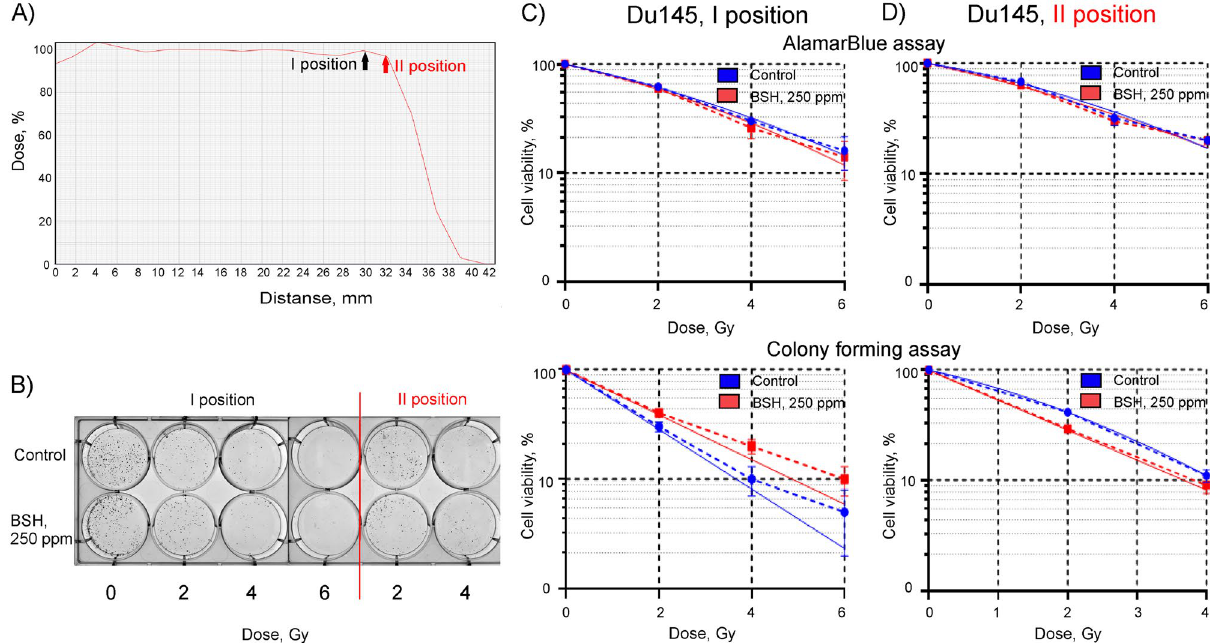
Figure 7. Effect of BSH on cell survivability after exposure to Bragg peak protons at different absorbed dose. ( A ) Dose profile for irradiation of cells with an 89.7 MeV clinical proton beam. In the majority of experiments, the cells were positioned at a depth of 30 mm (I position), and in some—at a depth of 32 mm (II position) along clinical proton SOBP. ( B ) Examples of colony forming assays for 7 h of incubation of Du145 cells with BSH (0 ppm (Control) or 250 ppm of boron-11) and proton beam irradiation at I position or II position of proton SOBP. ( C,D ) Plots for AlamarBlue (up panels) and colony forming assays (bottom panels) of Du145 cells. The cells were incubated in a medium containing 250 ppm of boron-11 and then irradiated by proton beam in a dose range of 0–6 Gy at ( C ) I position or ( D ) II position of SOBP of 89.7 MeV clinical proton